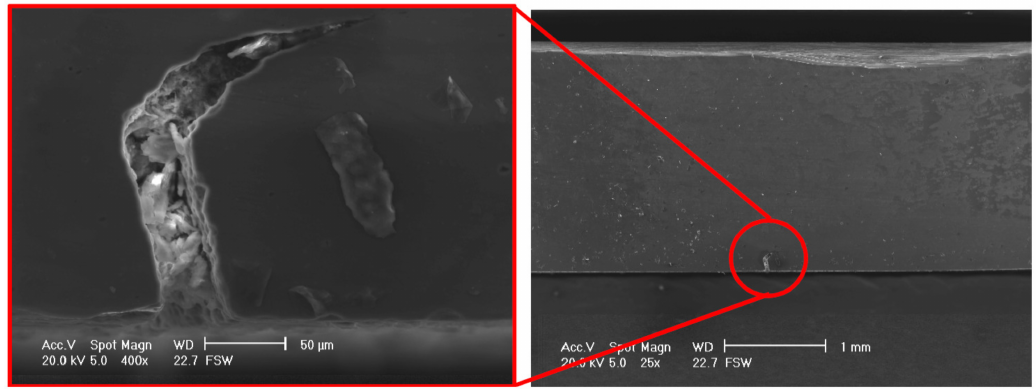
Figure 12. Scanning electron microscope (SEM) images showing the discontinuity located in the bottom side of the weld before cold rolling.